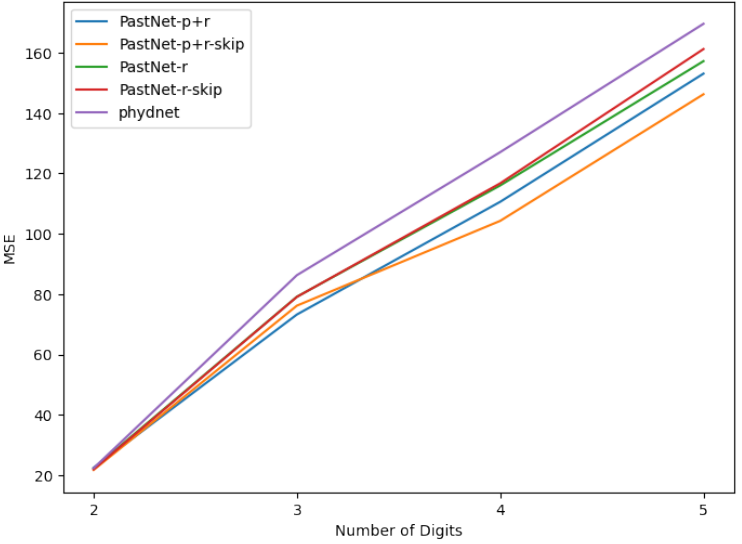
Figure 5. MSEs of trained models on Moving MNIST with different numbers of digits.